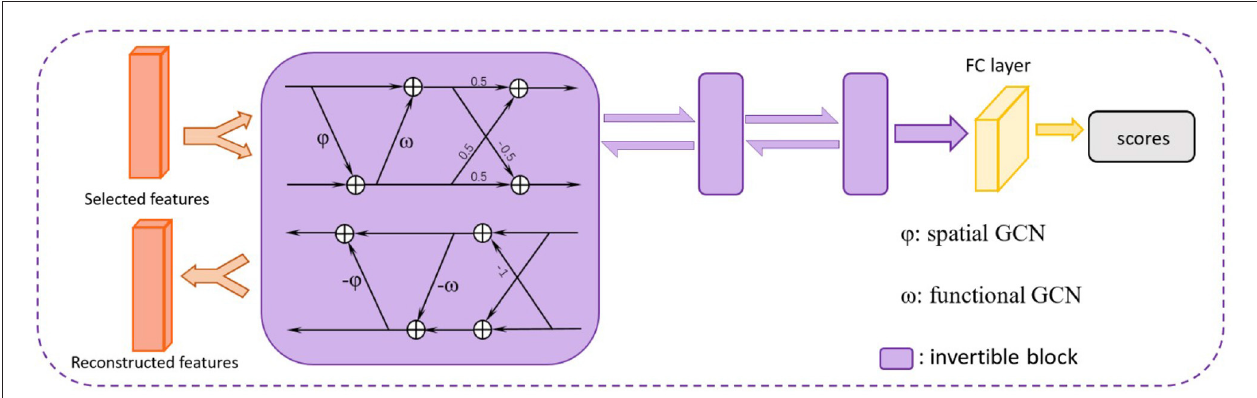
FIGURE 2 | The proposed ID-GCN architecture. The selected features are trained in three invertible blocks. A fully connected (FC) layer is finally used to obtain the output scores for ASD classification. The whole network is reversible before the FC layer, meaning that we can reconstruct the informative disease-related brain connectivity patterns by selecting important output features of the